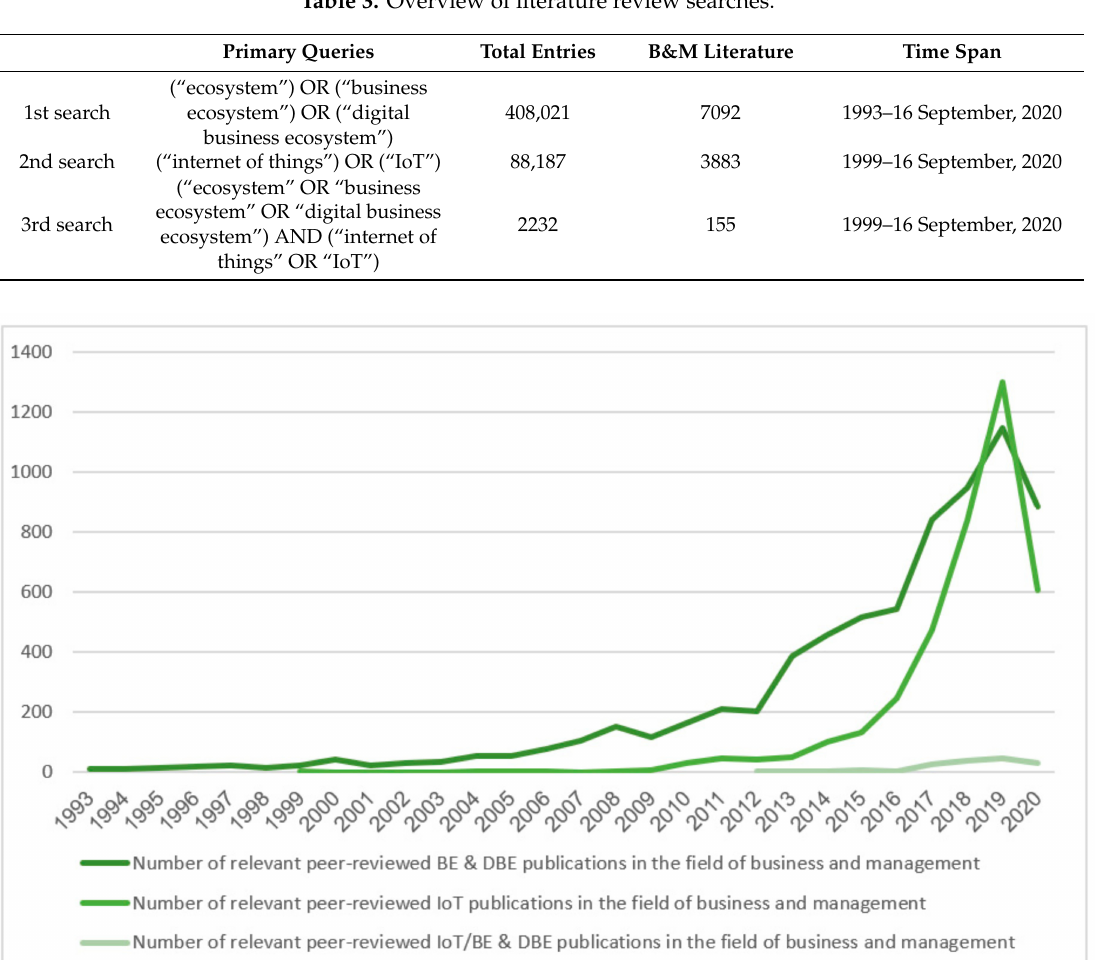
Figure 1. Relevant peer-reviewed literature search